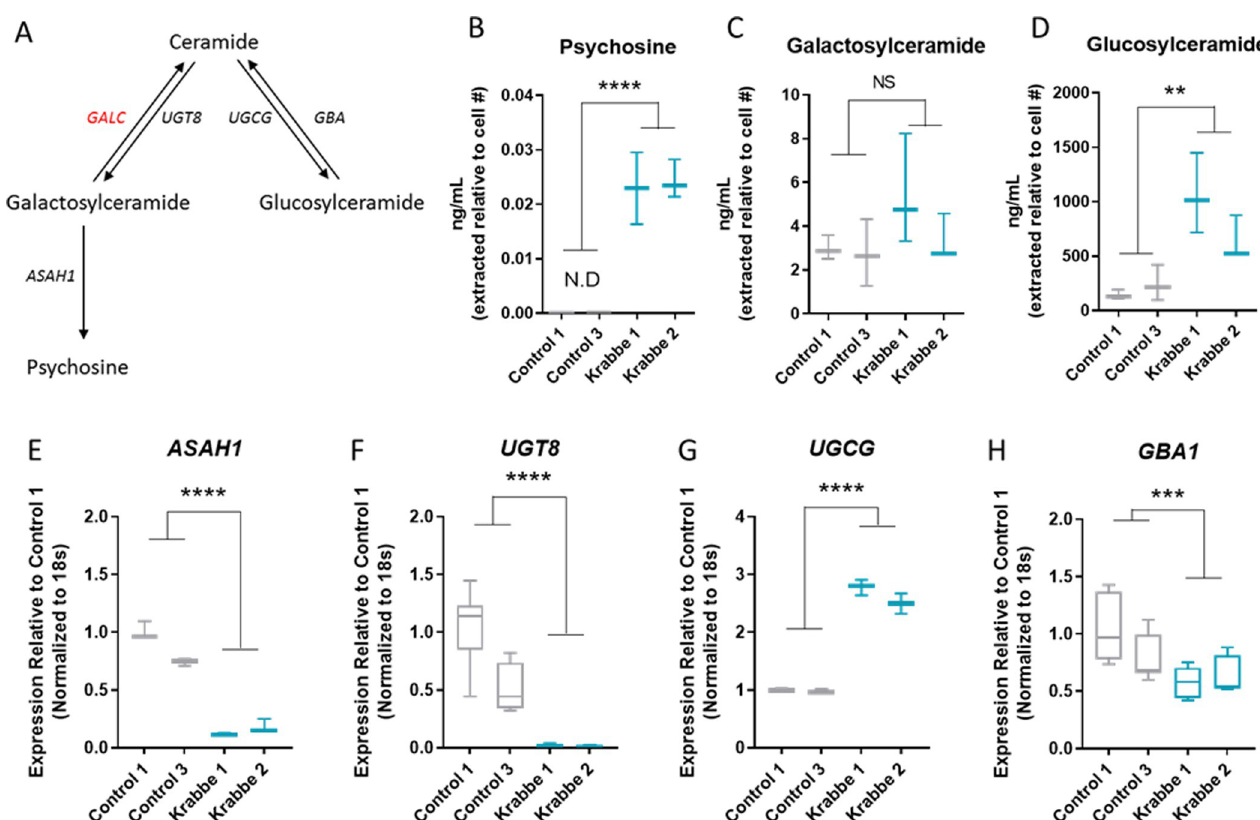
Fig 3. Lipid accumulation and compensatory gene expression changes in Krabbe astrocytes. (A) A simplified schematic of the glycosphingolipid pathway examined in the current study and the genes encoding the enzymes responsible for their biosynthesis. The gene encoding galactosylceramidase ( GALC ), which is defective in Krabbe disease, is indicated in red. (B) Astrocytes generated from the Krabbe donors had significantly elevated levels of psychosine. (C) No significant difference in total non-hydroxylated galactosylceramide was observed between control and Krabbe astrocytes. (D) Increased total non-hydroxylated glucosylceramide was observed in Krabbe astrocytes. (E-H) Compensatory changes in the expression of genes involved in the local glycosphingolipid biosynthesis pathway. For the galactosylceramide arm, a significant downregulation of genes encoding ceramide galactosyltransferase ( UGT8 ) and acid ceramidase ( ASAH1 ), which are responsible for the biosynthesis of galactosylceramide and psychosine, respectively, was observed in Krabbe astrocytes compared to controls. For the glucosylceramide arm, an upregulation of ceramide glucosyltransferase ( UGCG ) and downregulation of glucocerebrosidase 1 ( GBA1 ) was observed in Krabbe astrocytes compared to controls. �� p < 0.01, ��� p < 0.001, ���� p < 0.0001. Data for individual donor subjects is shown as a box and whisker plot with median represented and errors bars indicating min/max values. Statistical analysis was conducted using t-tests on pooled data comparing control vs. Krabbe cells. N.D. = not